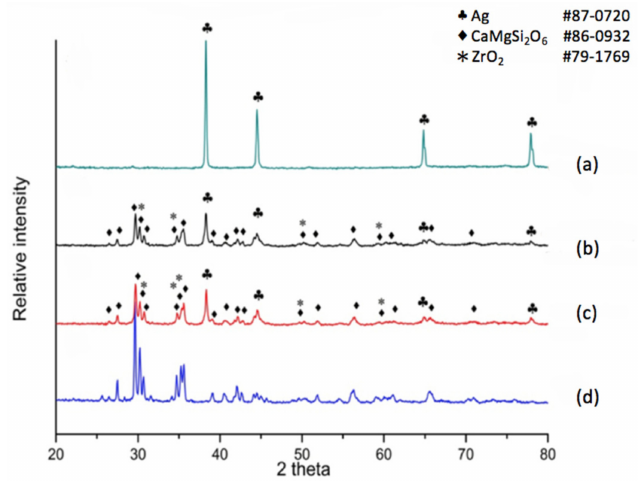
Figure 2. X-ray diffraction (XRD) patterns for different positions of a non-modified diopside CaO-MgO-2SiO 2 system co-fired with a commercial silver electrode paste. ( a ) Electrode surface; ( b ) below surface 20 µ m; ( c ) below surface 40 µ m; ( d ) crystallized CaO-MgO-2SiO 2